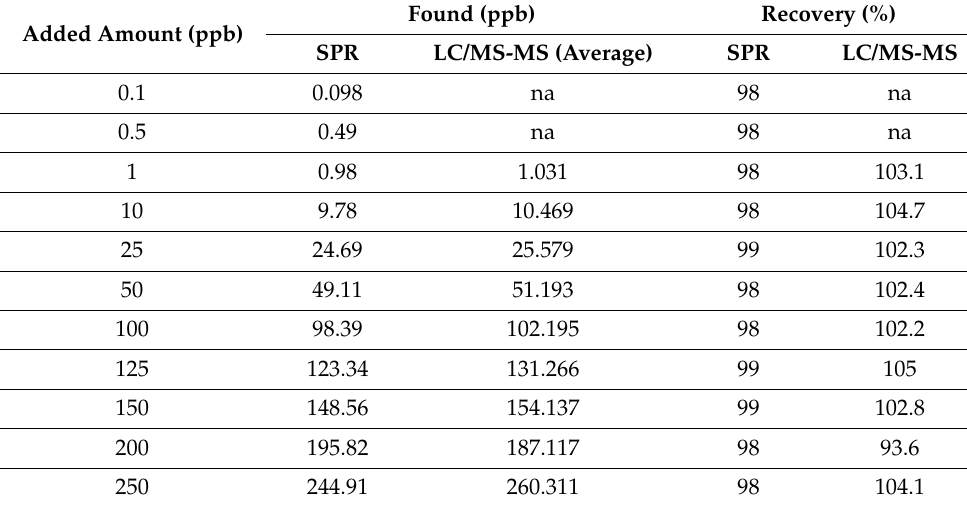
Figure 8. ( A ) Coumaphos LC-MS/MS retention time versus intensity graph. ( B ) Coumaphos calibra- tion graph. Table 4. CIP-SPR nanosensor validation study with LC-MS/MS system. Table 4. CIP-SPR nanosensor validation study with LC-MS/MS system.